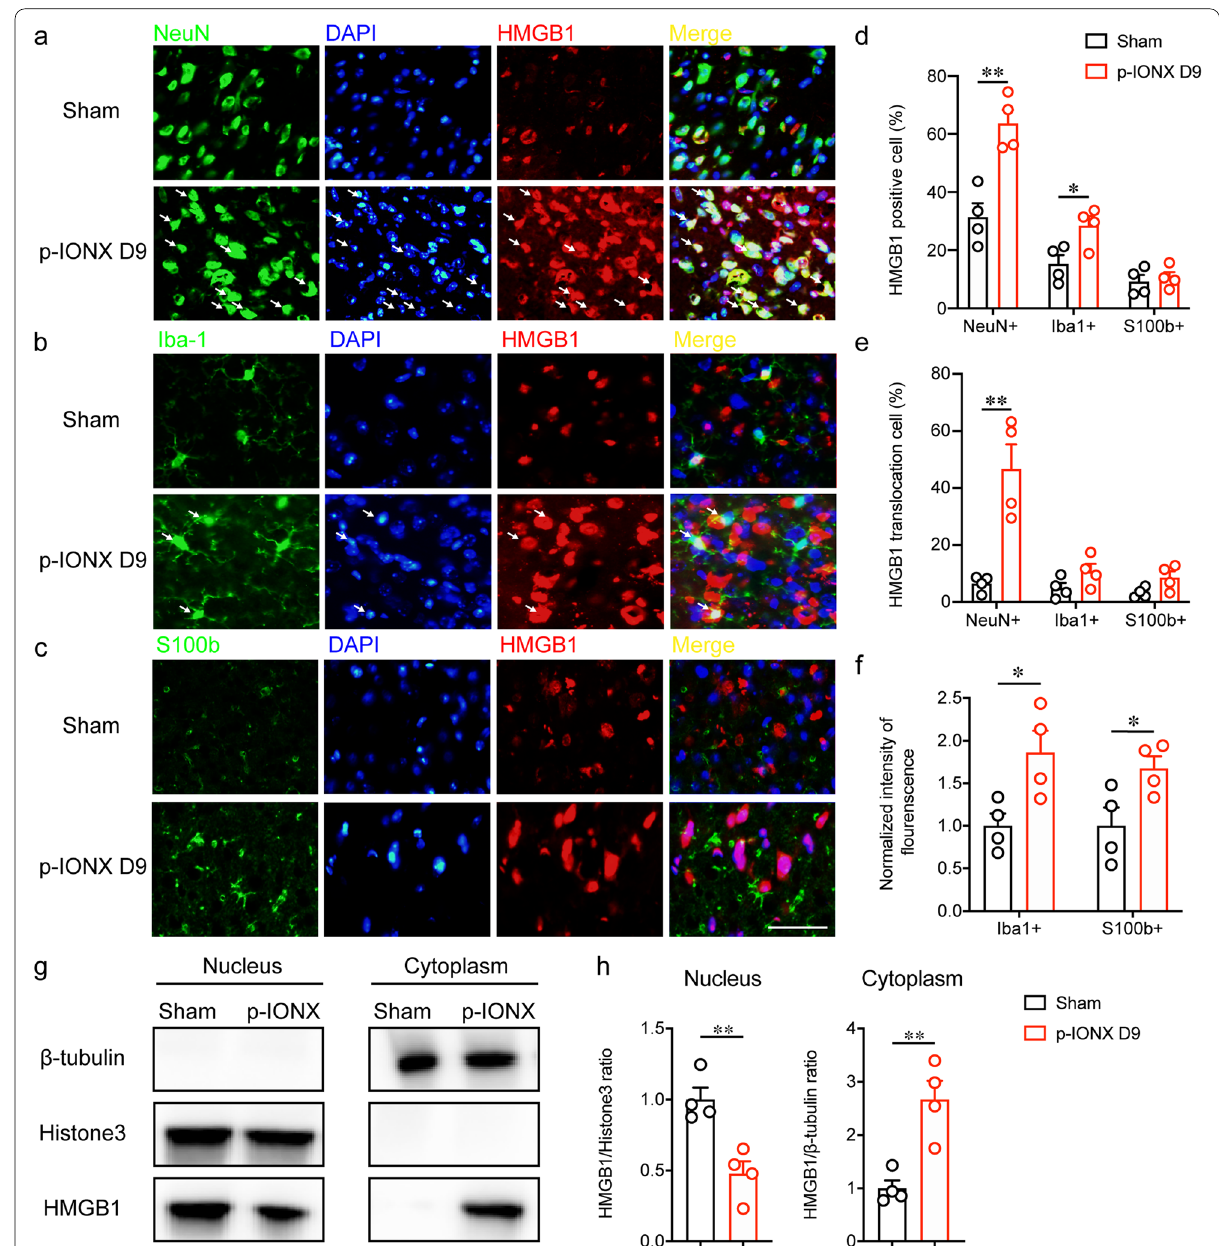
Fig. 3 Cellular and subcellular distribution of HMGB1 in the mPFC after p‑IONX in MRL/MPJ mice . a‑c Representative photomicrographs indicating the cellular distribution of HMGB1 in neurons (NeuN + , a ), microglia (Iba1 + , b ) and astrocytes (S100b + , c ) in the mPFC on D9 PO. DAPI was used to label nuclei. Scale bar, 50 μm. d Percentage of HMGB1‑positive cells in neurons (NeuN + ), microglia (Iba1 + ) and astrocytes (S100b + ) on D9 PO in the mPFC. e Percentage of cells with HMGB1 cytoplasmic translocation in neurons (NeuN + ), astrocytes (S100b + ) and microglia (Iba1 + ) on D9 PO in the mPFC. f Quantification of Iba1 and S100b fluorescence intensity in the mPFC. g‑h Representative images of western blot bands ( g ) and quantification of HMGB1 ( h ) in nuclear and cytoplasmic fractions from the mPFC on D9 PO. * and ** indicate P < 0.05 and 0.01, respectively, compared with the indicated groups, unpaired t test. n =